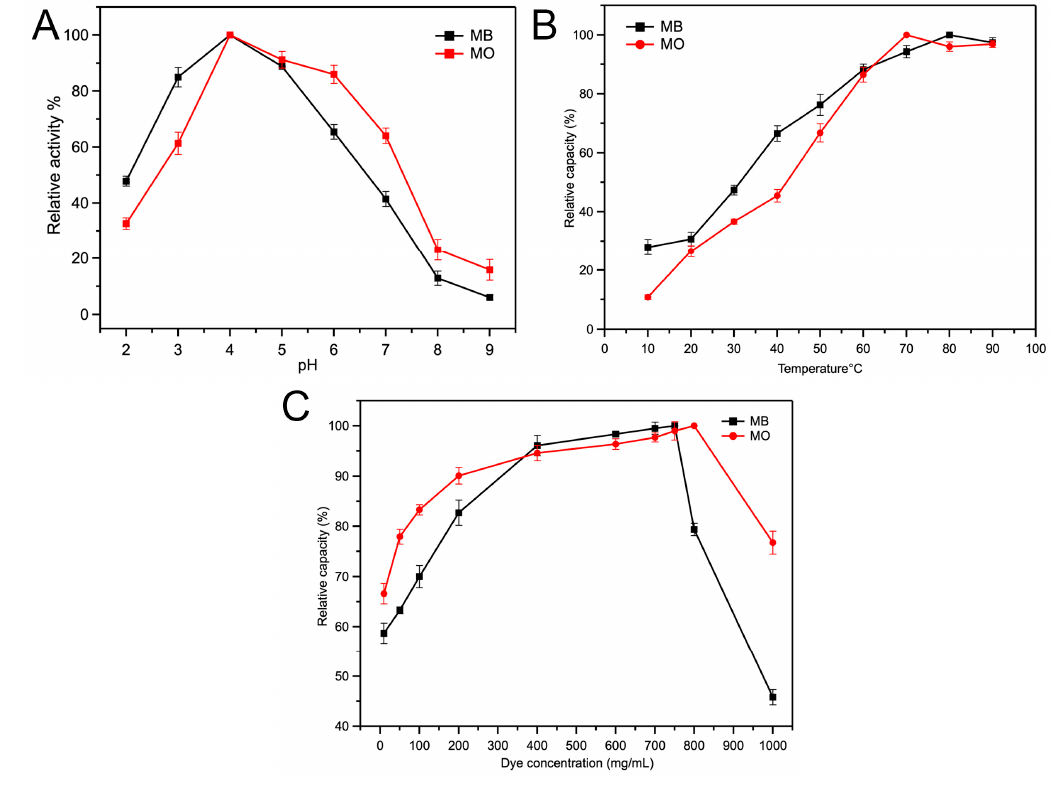
Figure 8. The activity of degradation in MO and MB by Fe-loaded MOF-545(Fe) with H 2 O 2 . ( A ) Degradation of MO and MB from pH 2.0–9.0. ( B ) Degradation of MO and MB from 10 ◦ C to 90 ◦ C. ( C ) Dyes’ concentrations on the activity of degradation MB and MO of Fe-loaded MOF-545(Fe).